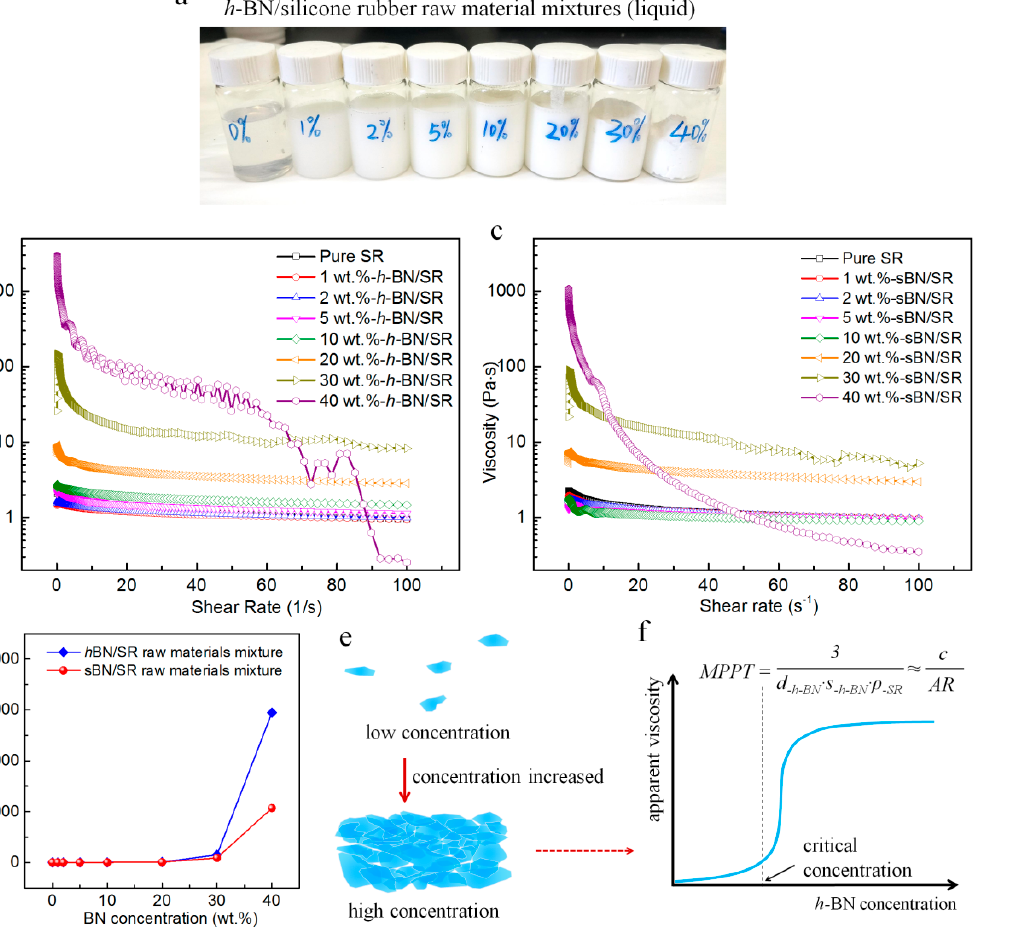
Figure 10. Studies on the high-viscosity problem. ( a ) Photograph showing some rheological test samples. ( b ) Shear viscosity curves of h- BN/SR raw material mixtures. ( c ) Shear viscosity curves of s BN/SR raw material mixtures. ( d ) Plots of the maximum viscosity on every curve against the BN concentration. ( e ) Scheme diagram of the dispersion states of h- BN sheets at low and high concentrations. ( f ) h- BN’s dispersion systems usually have a high-viscosity problem around their Most Probable Percolation Threshold (MPPT) concentration. It is mainly affected by the lateral size ( d - h- BN ) and specific surface area of h- BN ( S -h- BN ), and the density of silicone rubber’s raw materials ( ρ -SR ); or the aspect ratio of h- BN (AR) (c is an indeterminate